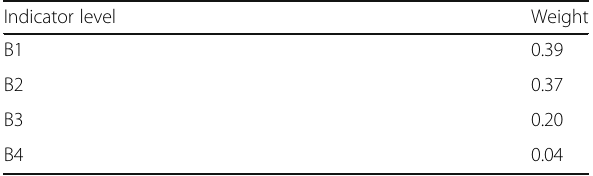
Table 7 The judgement matrix of the first-level indicators.